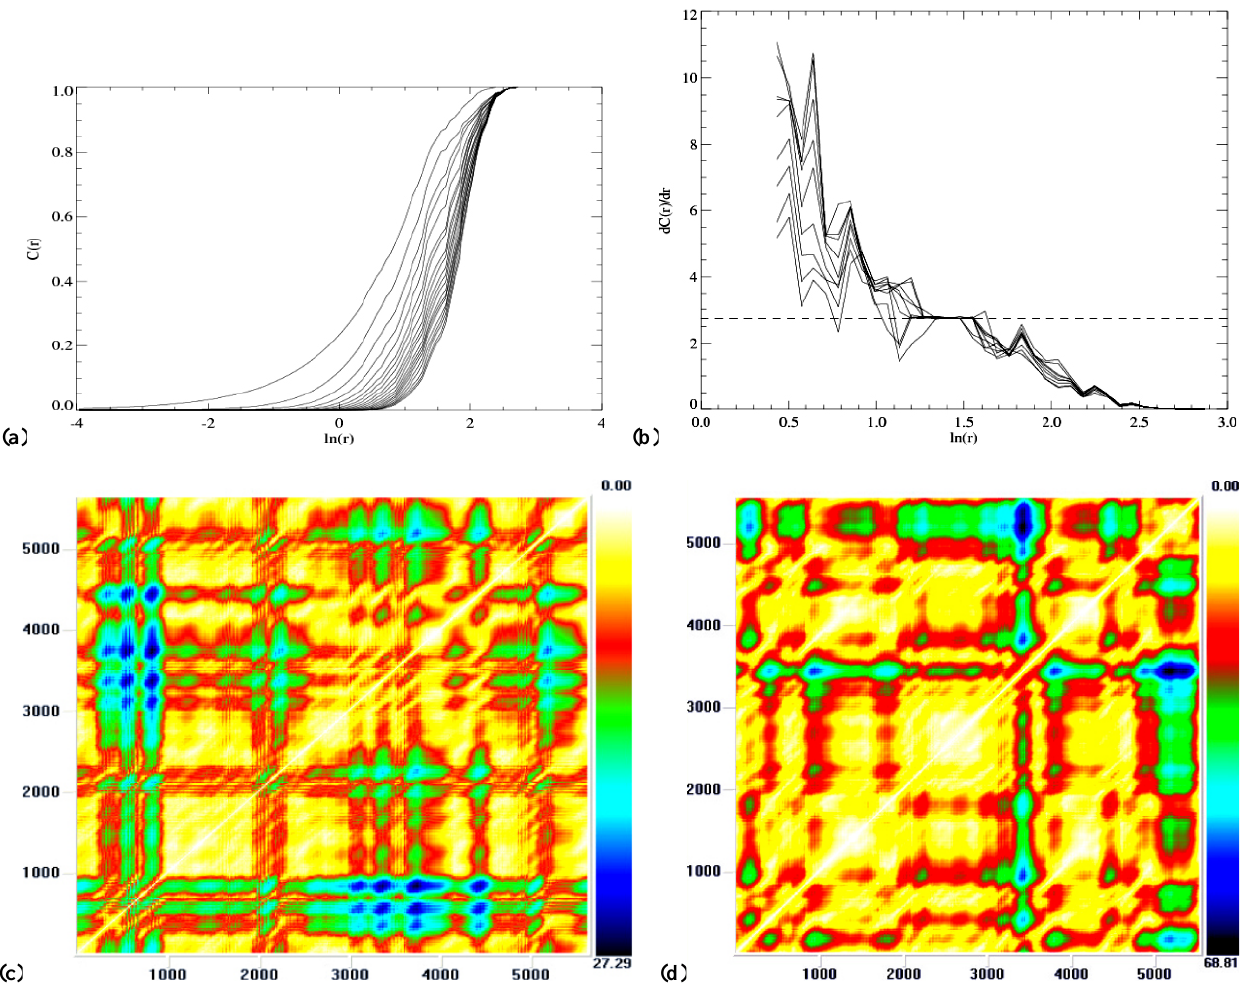
Fig. 4. Plots of (a) the correlation sum (b) the local slopes of the logarithms of correlation sum of detrended TEC time series measured at Agatti showing the dimension of the attractor, for m ranging from 7 to 19, with τ = 20, ω = 200, and (c) the Recurring Plots (RPs), which exhibit characteristic patterns for quiet and (d) storm